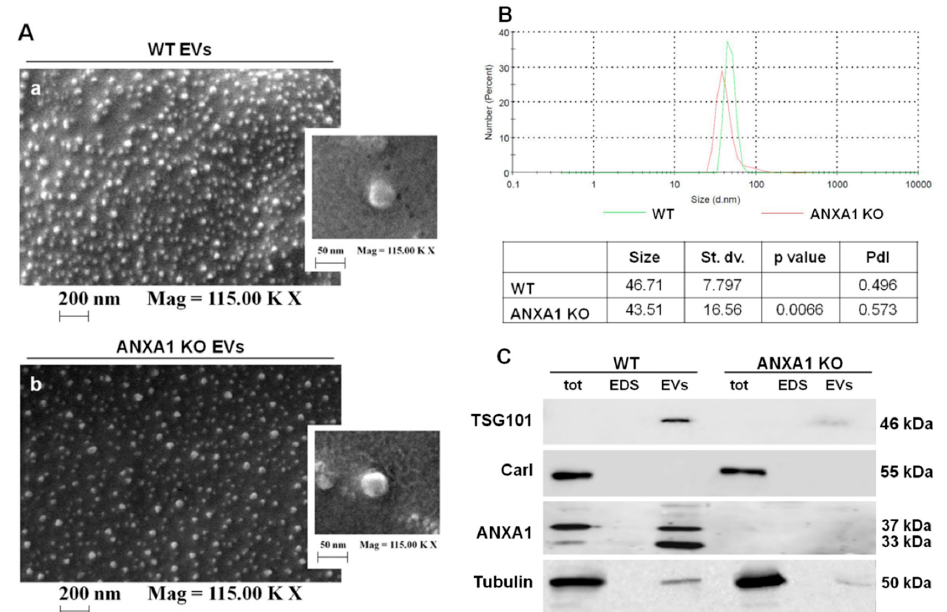
Figure 1. Analysis of extracellular vesicles (EVs) deriving from wild type (WT) and annexin A1 (ANXA1) knock-out (KO) MIA PaCa-2 cells. ( A ) EVs isolated from WT (a) and ANXA1 KO (b) MIA PaCa-2 cells were imaged by Field Emission Scanning Electron Microscopy (FE-SEM). Magnitude = 11,500 KX (that is 115,000) and scale bar = 200 nm. For the magnification: magnitude 11,500 KX (that is 115,000) and scale bar = 50 nm ( B ) Characterization of the EVs size distributions by dynamic light-scattering (DLS). The table reports the EVs mean of size, standard deviation, p value, referring to ANXA1 KO EVs distribution vs. WT, and PdI. The experiments were performed in triplicate. ( C ) Western blot using antibodies against TSG101, calreticulin, and ANXA1 on protein content of total cell lysates, EV-depleted extracellular fractions (EDS) and EVs fractions extracted from WT and ANXA1 KO MIA PaCa-2 cells. Protein normalization and the check of the sample quality were performed on tubulin